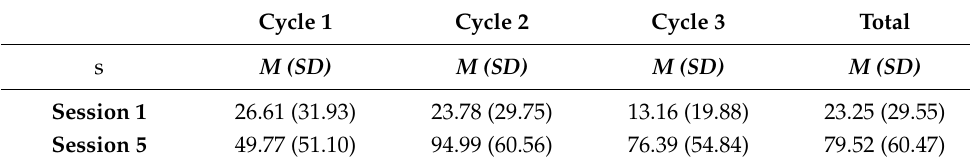
Table 1. HRV means ( M ) and standard deviations ( SD ) for the three primary school